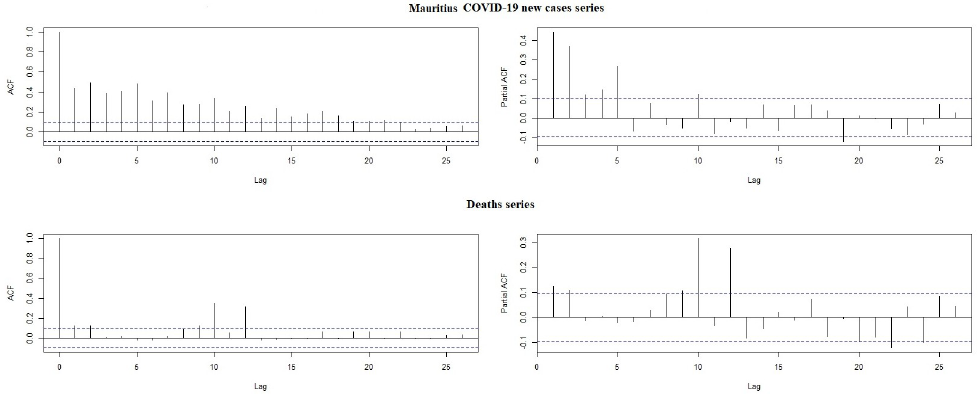
Fig 4. The ACF and PACF plots for COVID-19 new cases and death